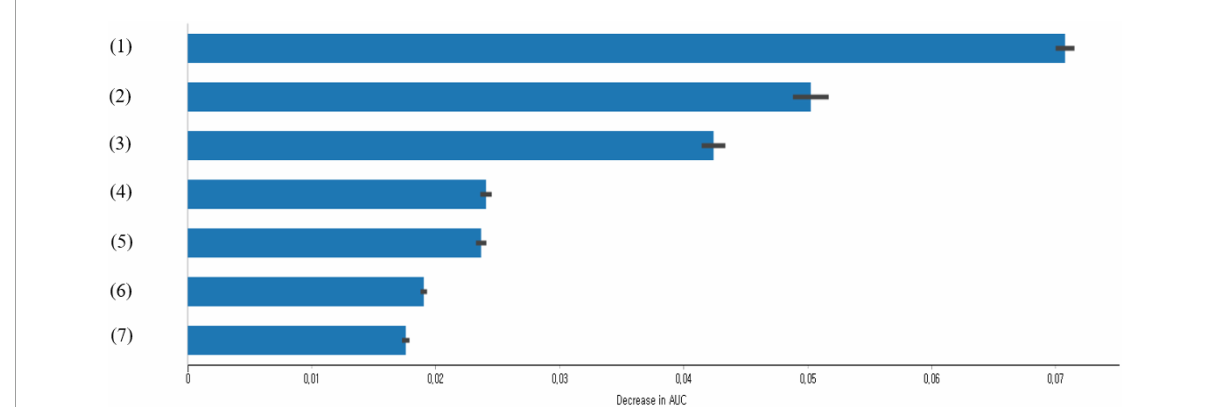
FIGURE1 The features importance of factors related to the suicidal ideation of adolescents using XGBoost (only top seven factors are presented): (1) depression experience in the past 12 months; (2) subjective stress recognition; (3) experience of loneliness in the past 12 months; (4) academic performance; (5) grade; (6) household economic status; and (7) changes in economic status due to COVID-19.